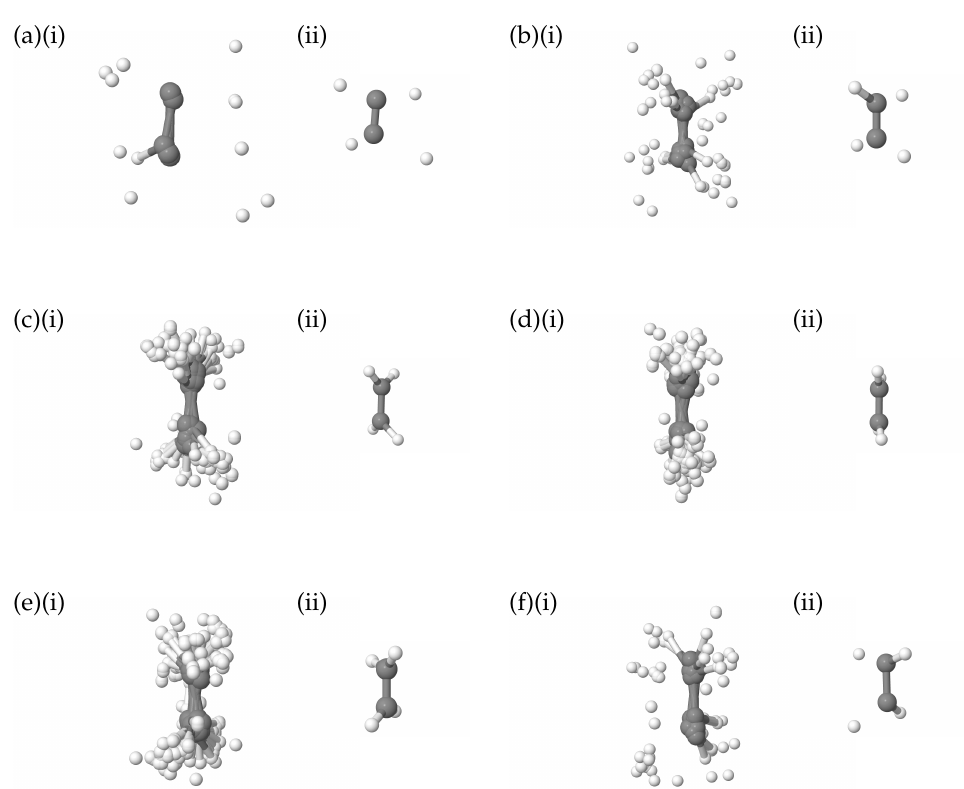
Figure 7. Geometries of salicylaldimine grouped according to their associated diffusion coordinate, θ 2 : ( a ) − 0.18 < θ 2 < − 0.13; ( b ) − 0.13 ≤ θ 2 < − 0.08; ( c ) − 0.08 ≤ θ 2 < − 0.03; ( d ) − 0.03 ≤ θ 2 < 0.03; ( e ) 0.03 ≤ θ 2 < 0.08; ( f ) 0.08 ≤ θ 2 < 0.13. In each case plot (i) represents all sampled geometries within the diffusion coordinate domain, whilst plot (ii) is the average of the sampled geometries in the corresponding plot